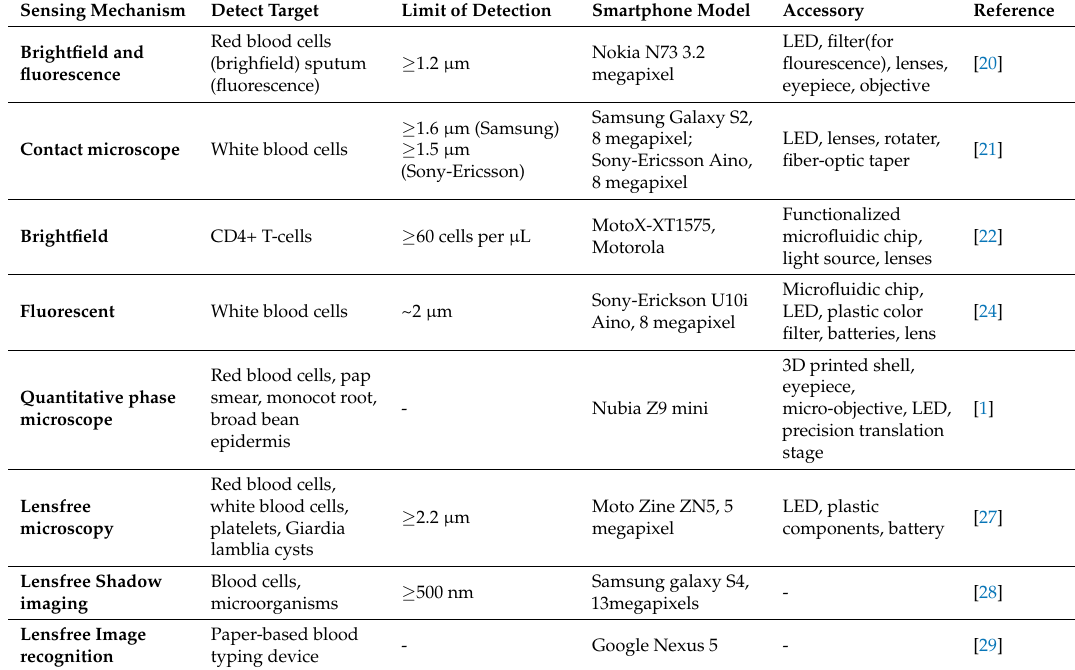
Table 1. Biosensor based on imaging on smartphone